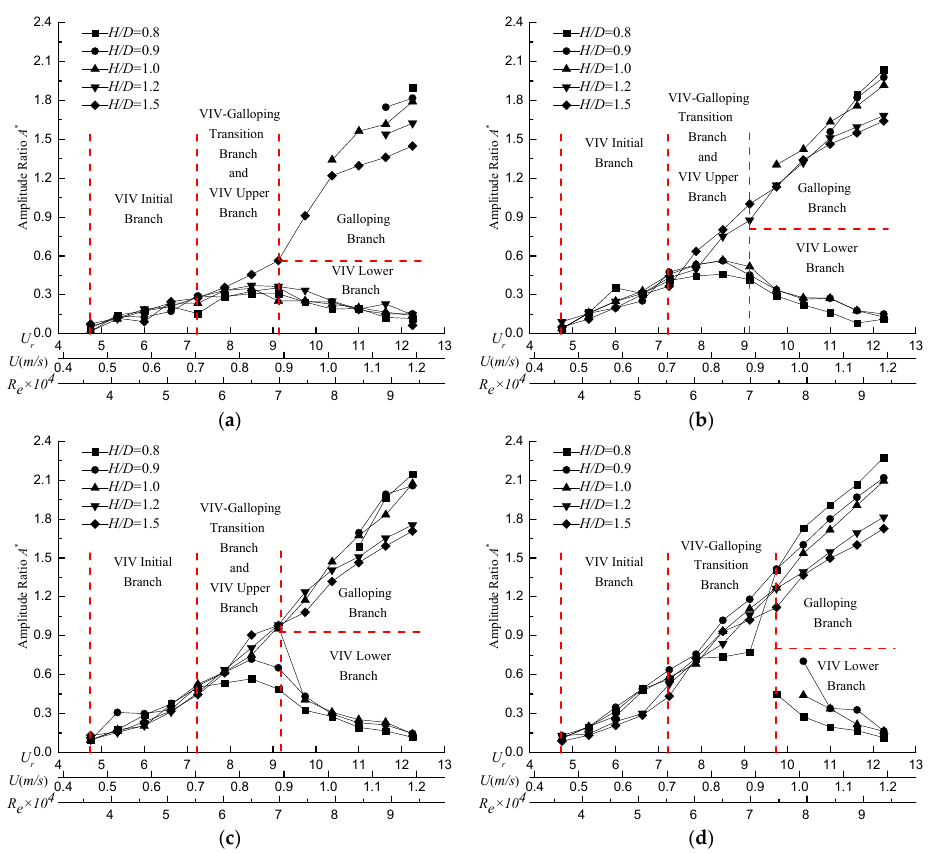
Figure 19. Oscillation characteristics with different section aspect ratios at K = 1200 N/m: ( a ) amplitude ratio (4 Ω , ζ = 0.347); ( b ) amplitude ratio (8 Ω , ζ = 0.305); ( c ) amplitude ratio (11 Ω , ζ = 0.246); ( d ) amplitude ratio (16 Ω , ζ = 0.177).